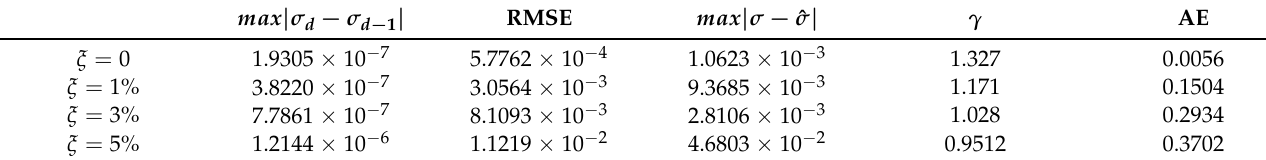
Figure 2. Recovered volatility function against exact one with noise. Table 2. The numerical results of recovered σ ( τ ) and γ